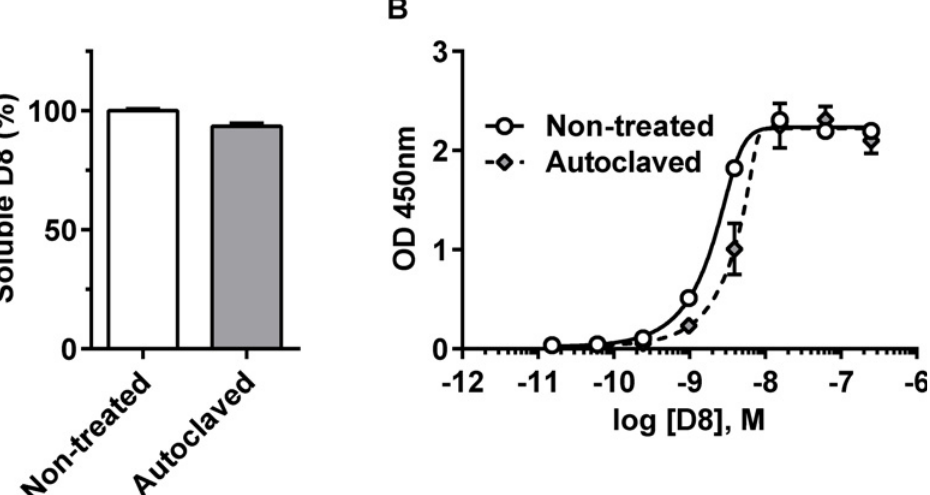
Fig 3. Anti-GFP Nanofitin D8 binding after heat-treatment by autoclaving. (A) Quantitation of soluble fraction of the Nanofitin D8 proteins before (white bar) and after (grey bar) autoclaving treatment (n = 3). (B) The interaction of purified Nanofitin D8 before and after sterilization process by autoclaving, respectively in plain and dashed lines, was assessed by ELISA with immobilized StrepTagII-GFP and concentration range of the Nanofitin (n = 3).